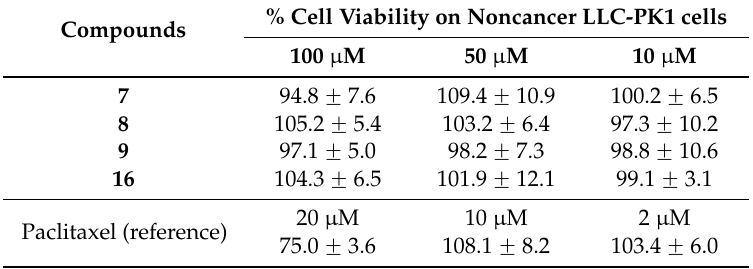
Table 4. Cytotoxic properties of the potent synthesized heterocyclic chalcones on noncancerous LLC-PK1